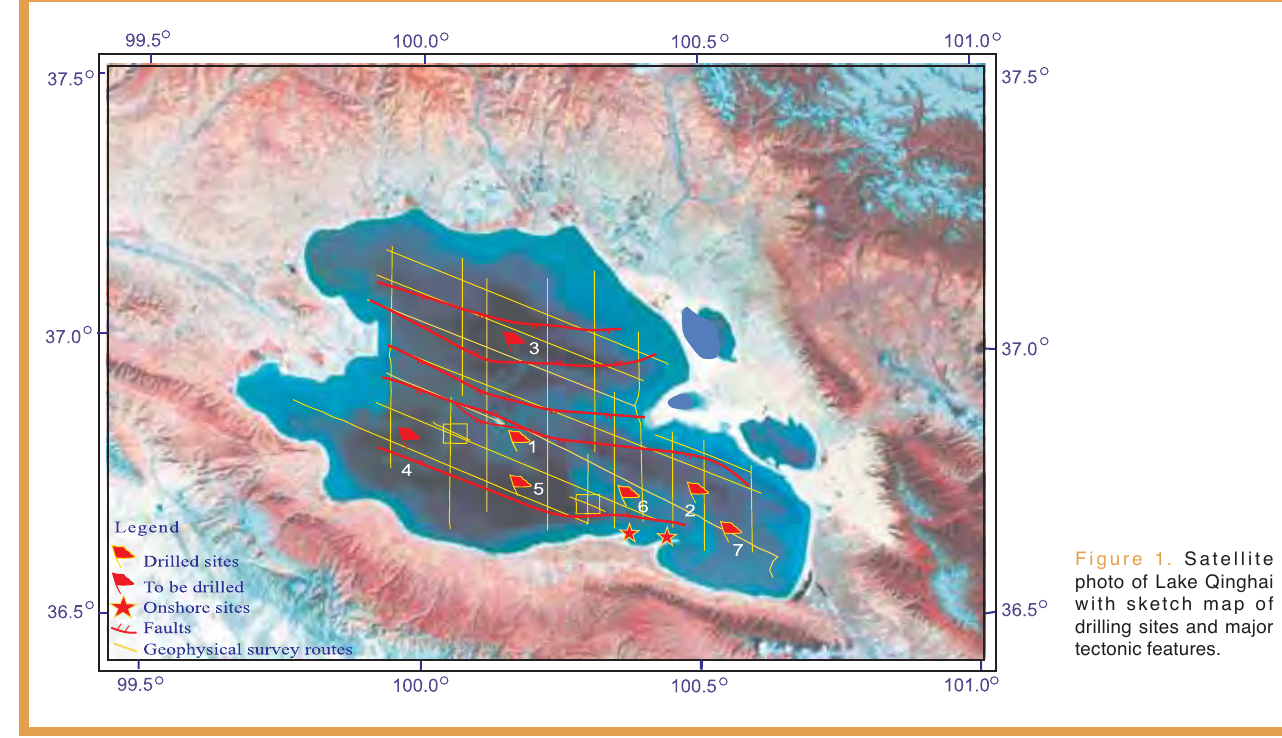
Figure 1. Satellite photo of Lake Qinghai with sketch map of drilling sites and major tectonic